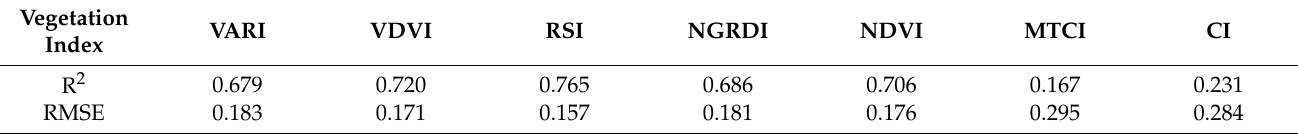
Table 2. Model fitting effect